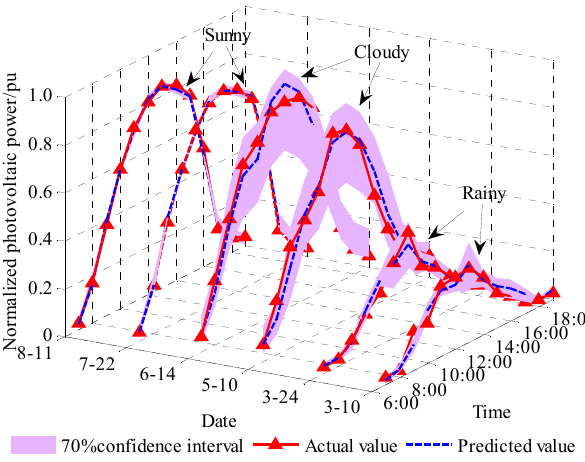
Figure 6. The predicted results under 90% confidence interval.